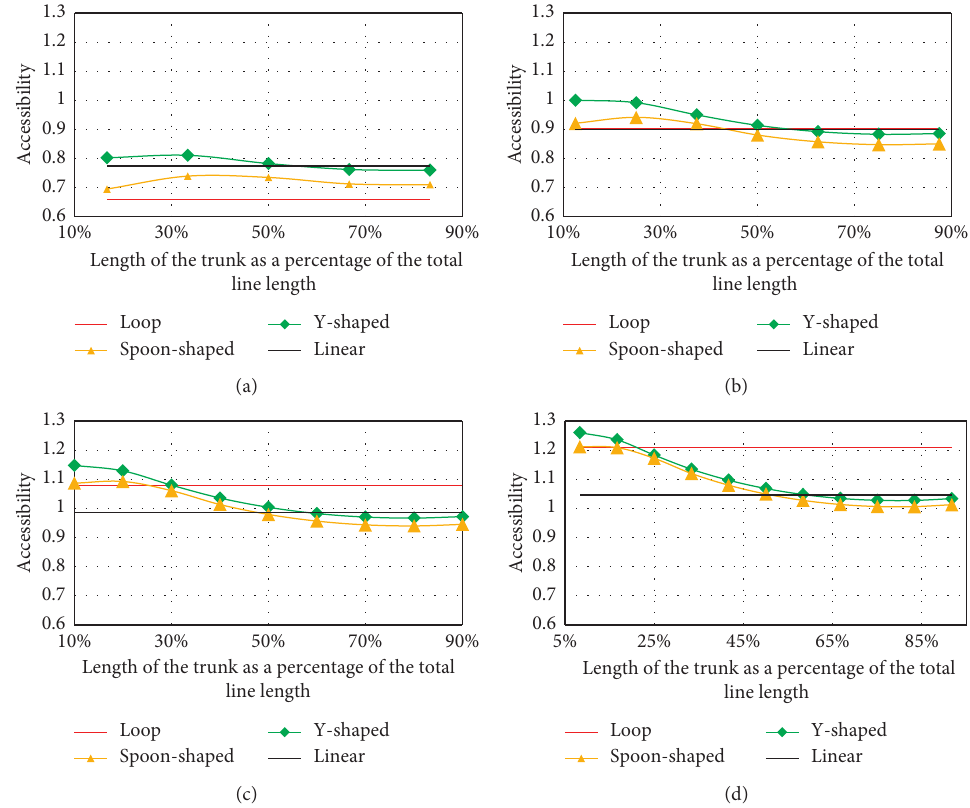
Figure 7: Variation of the accessibility with the length of the trunk as a percentage of the total line length. (a) Line length � 6km. (b) Line length � 8 km. (c) Line length � 10km. (d) Line length � 12km. Table 2: The accessibility calculation formulas of the linear lines whose transfer stop is an intermediate stop. Explanation There are n stops on one branch including the stop at the branch point and m stops on the other